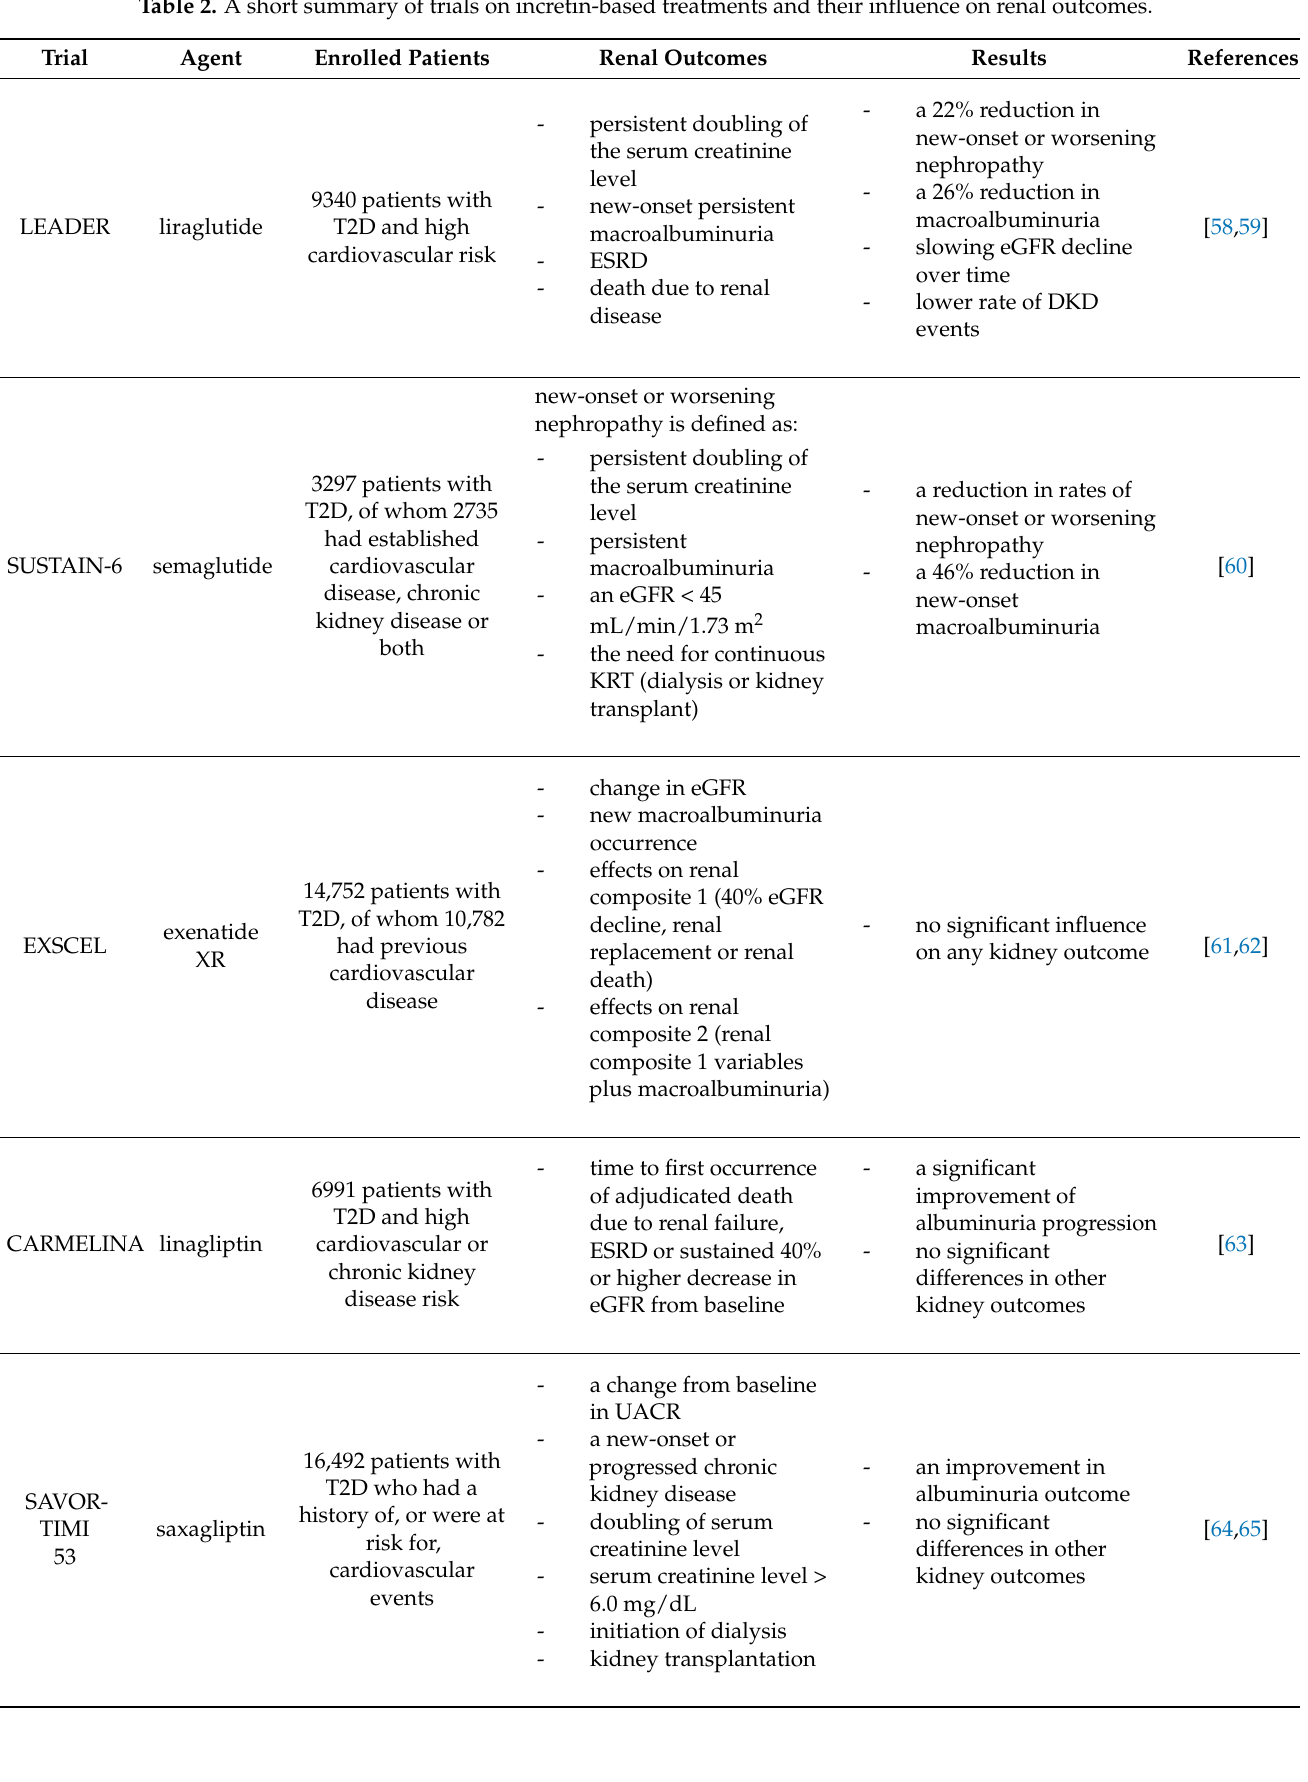
Table 2. A short summary of trials on incretin-based treatments and their influence on renal outcomes. Trial